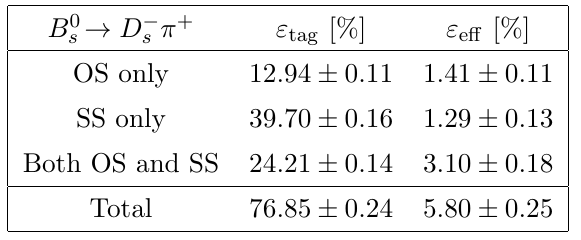
D (cid:0) (cid:25) + candidates tagged by OS only, SS s ! s